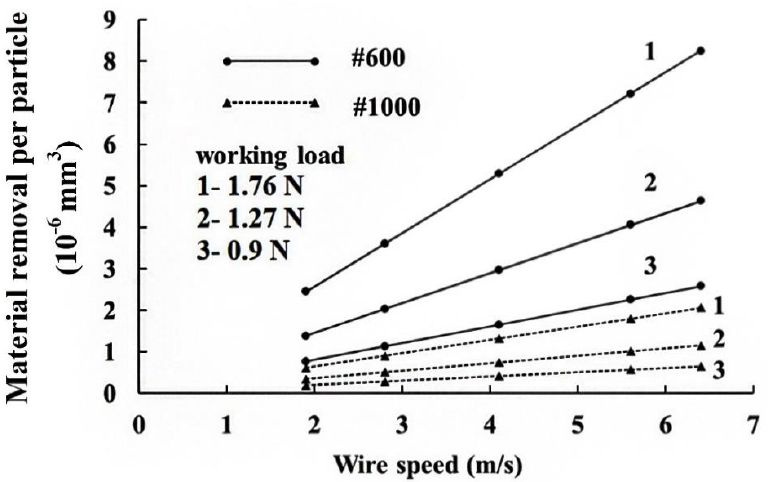
ff erent size of